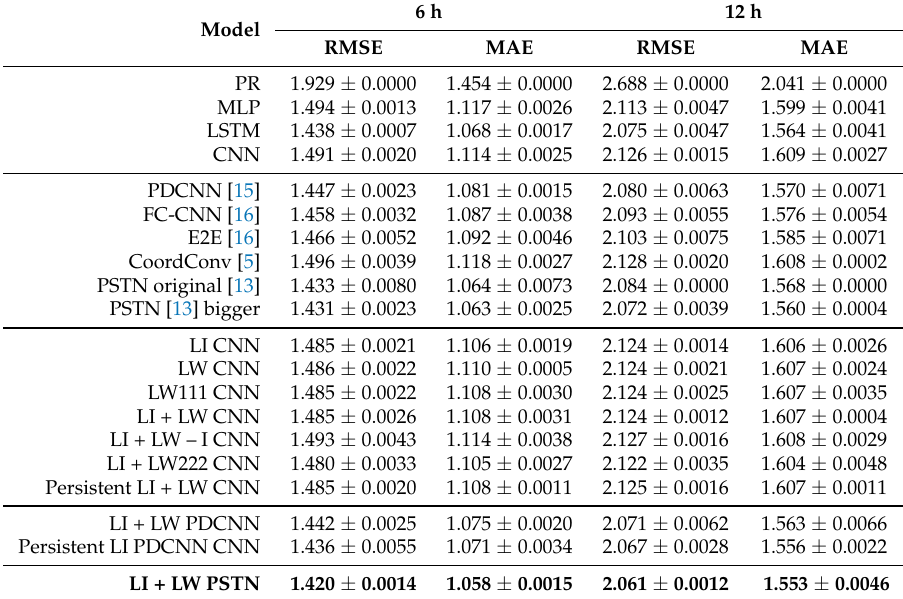
denotes standard ±